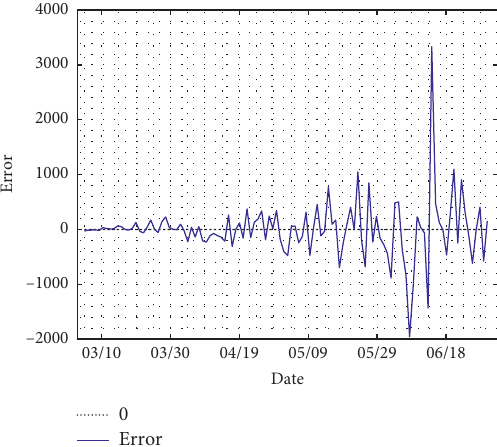
Figure 14: The fitting error of Brazil with an average absolute error of